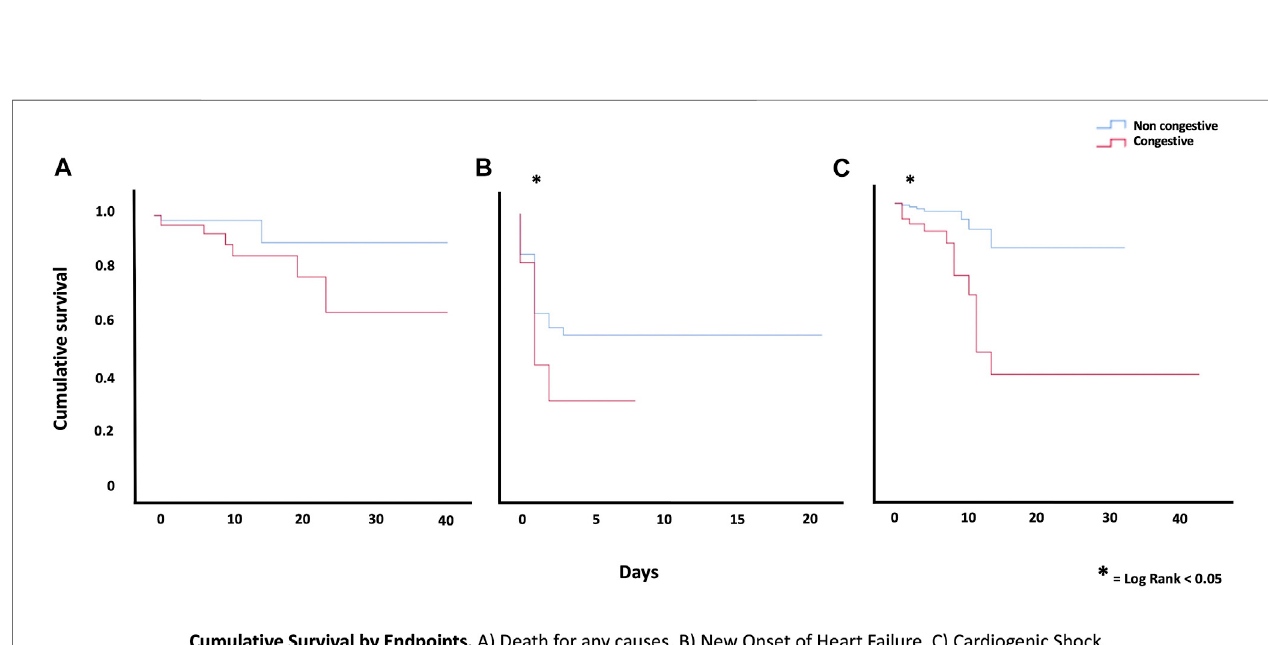
FIGURE 4 | Cumulative Survival by Endpoints. (A) Death for any causes. (B) New Onset of Heart Failure (C) Cardiogenic Shock.